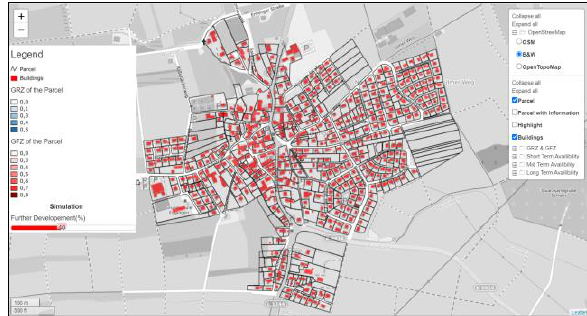
Figure 8 : Web GIS Application showing the Basic Features